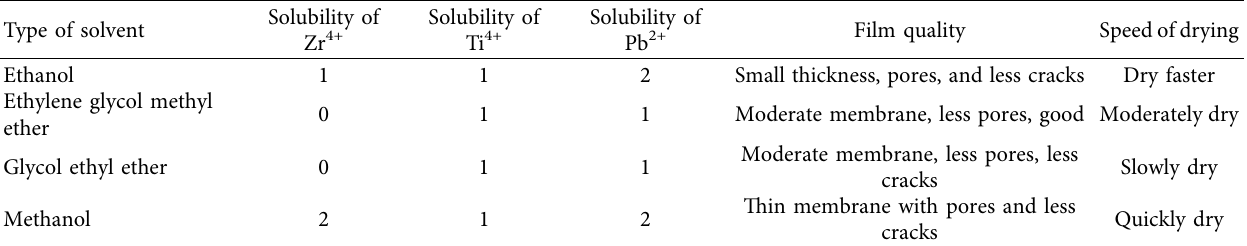
Table 1: The influence of solvents on the quality of film